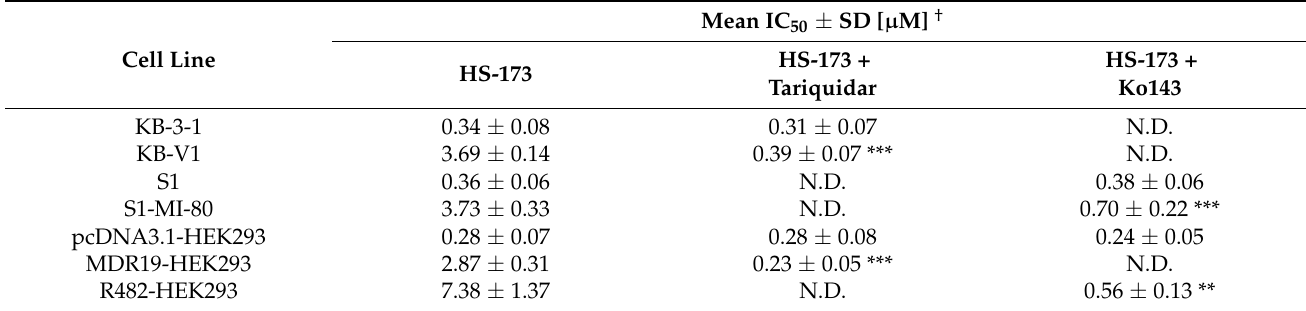
Table 2. Effect of reference inhibitors of ABCB1 and ABCG2 on the cytotoxicity of HS-173 in cells overexpressing ABCB1 or ABCG2.